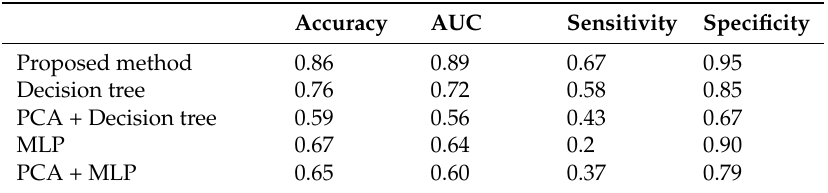
Table 5. Accuracy